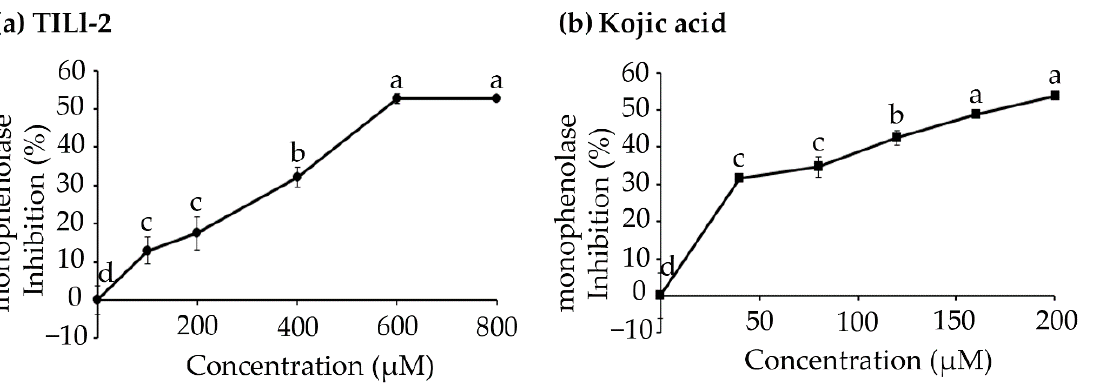
Figure 1. The effect of ( a ) TILI-2 peptide and ( b ) kojic acid on monophenolase inhibitory activity. TILI-2 was incubated with tyrosinase and L-tyrosine at various concentrations from 0 to 800 µM. As a control, kojic acid was used at concentration from 0 to 200 µM. Monophenolase inhibition (%) = (1 − A/B) × 100, where A and B are the initial rates ( ∆ A475/min) of the enzyme reaction with and without the peptide inhibitor, respectively. All values represent the mean ± SD. Different letters indicate the significant differences from Duncan’s test ( p < 0.05).